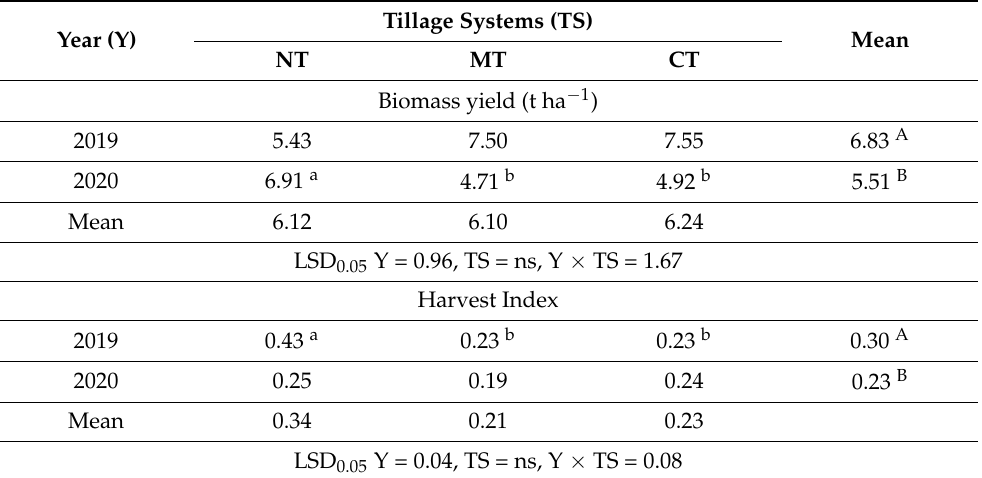
Table 4. Influence of soil tillage systems on biomass yield and harvest index during the 2019 and 2020 growing seasons ( p < 0.05).